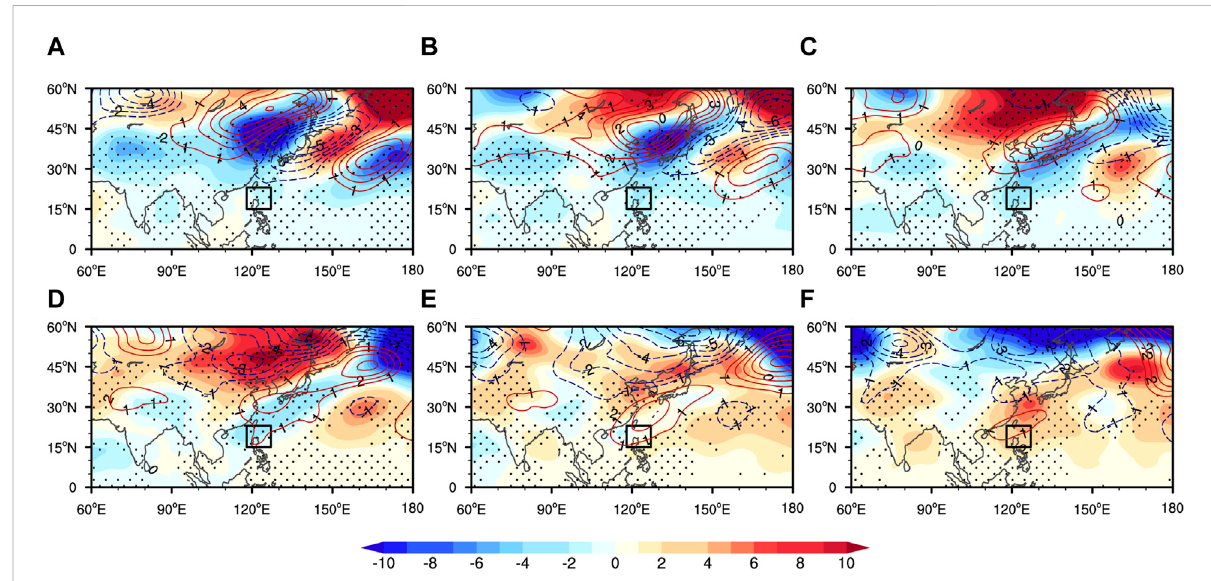
FIGURE 11 The quasi-biweekly-scale geopotential height anomaly (shading) and its tendency (contour) from day -10 to day 0 during the Meiyu onset period (A-F) (unit: gpm; black box: the low latitude key region; dots are the areas with statistical signi fi cance exceeding the 95% level).